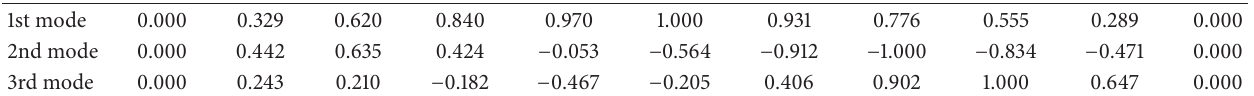
Table 5: Optimal mode shapes (Case 1).